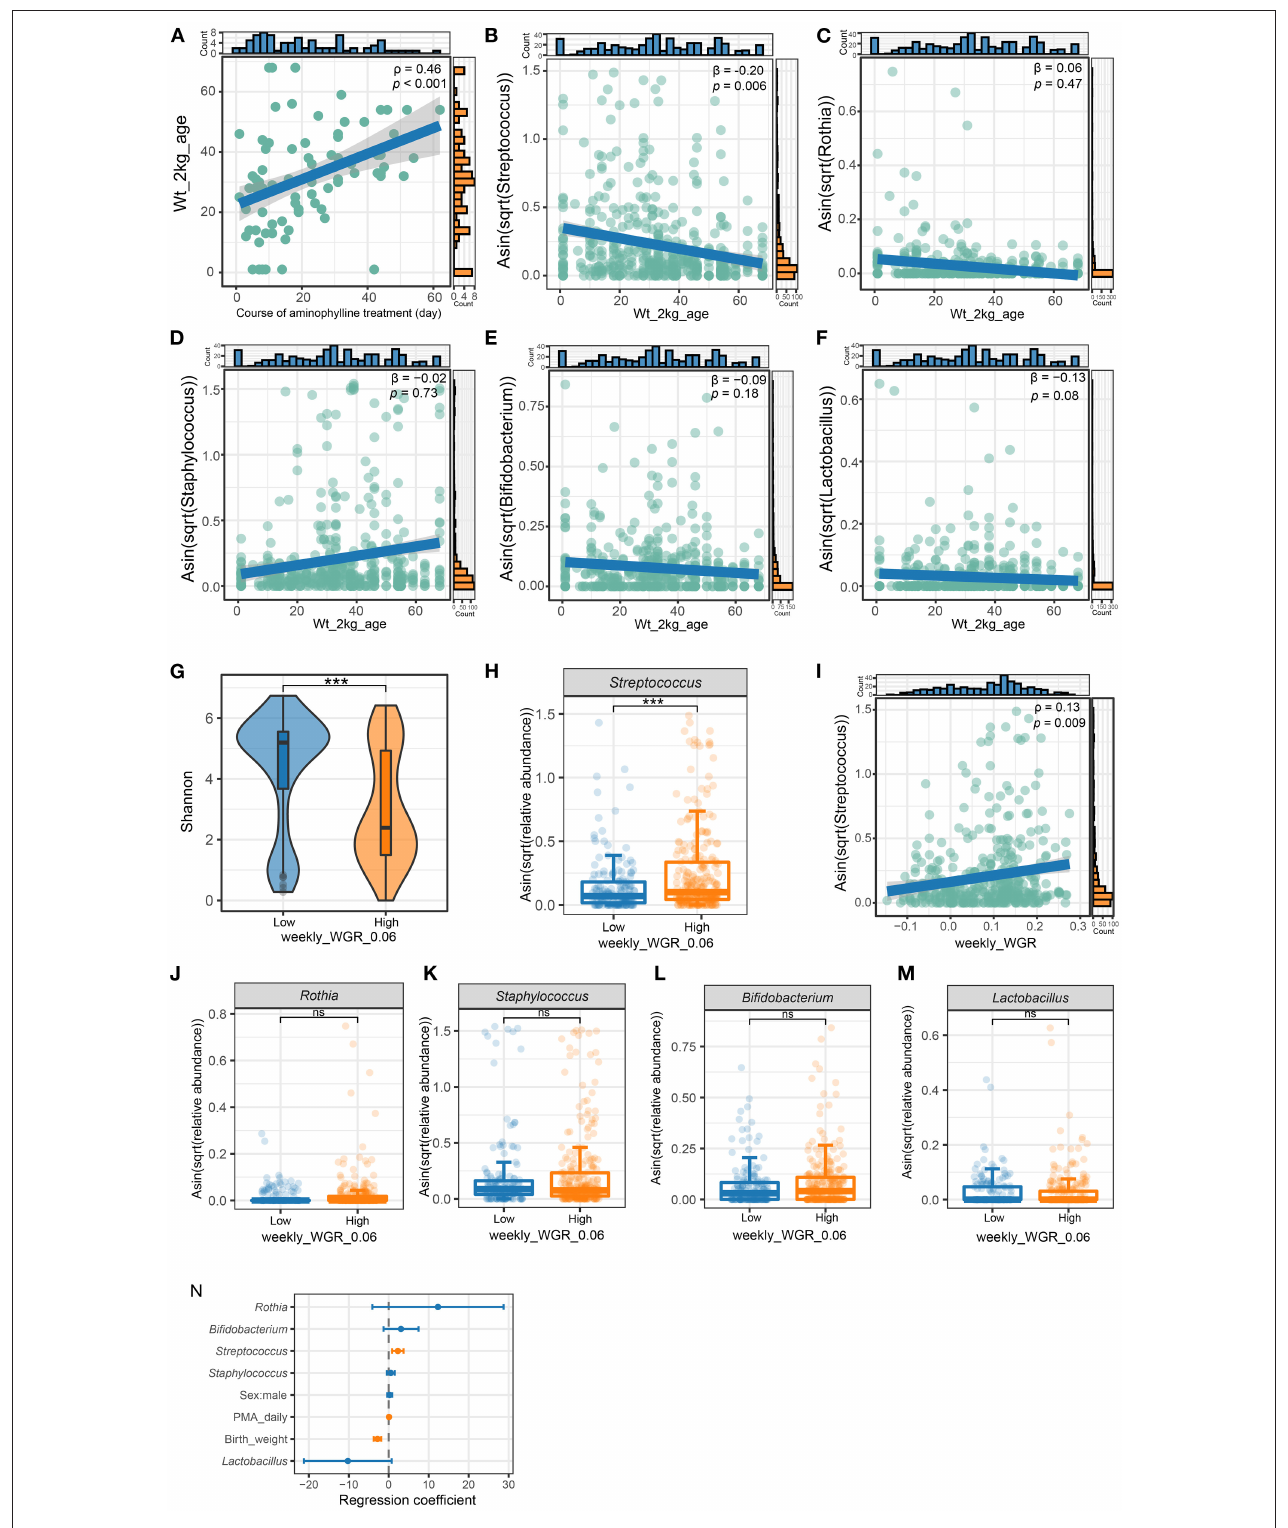
FIGURE 6 | The relationship of weight gain with microbiome and aminophylline. (A) The correlation between age in days when the patient’s weight reached two kilograms and the course of aminophylline in patients taking aminophylline. (B – F) The correlation between age in days when the patient’s weight reached